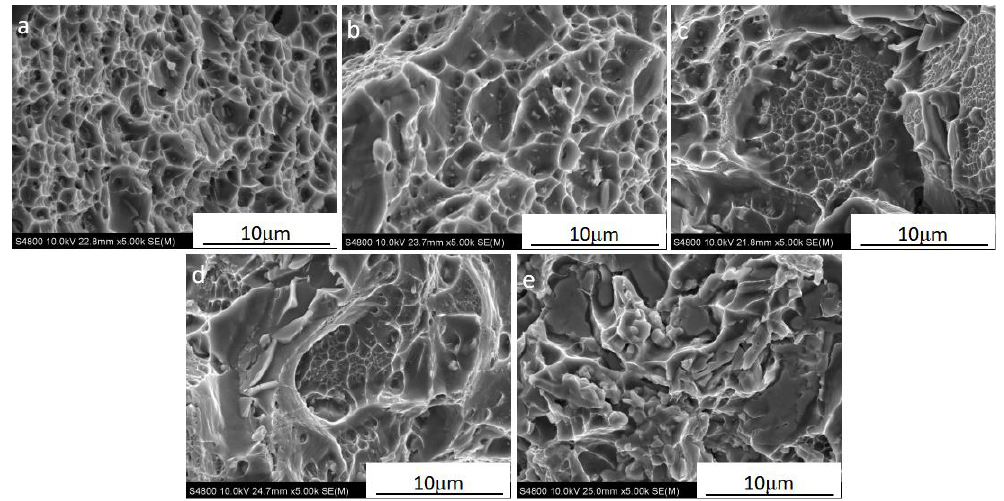
Figure 10. Fracture morphologies of different heat input deposits. ( a ) 30 J/mm; ( b ) 60 J/mm; ( c ) 90 J/mm; ( d ) 120 J/mm; ( e ) 150 J/mm.